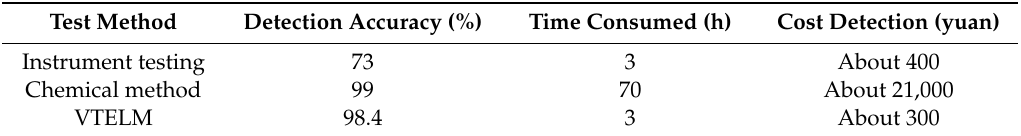
Table 4. Comparison of detection